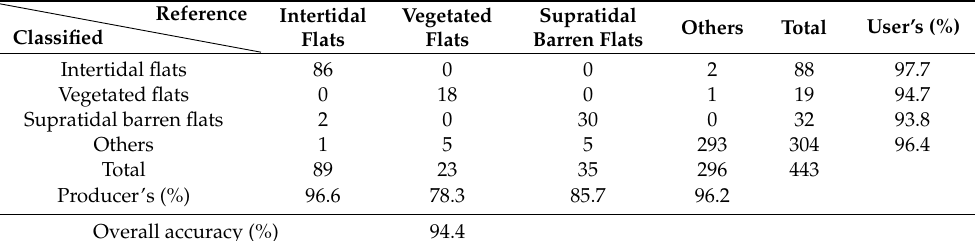
Table 2. Confusion matrix for assessing the performance of proposed approach here for mapping tidal flats.